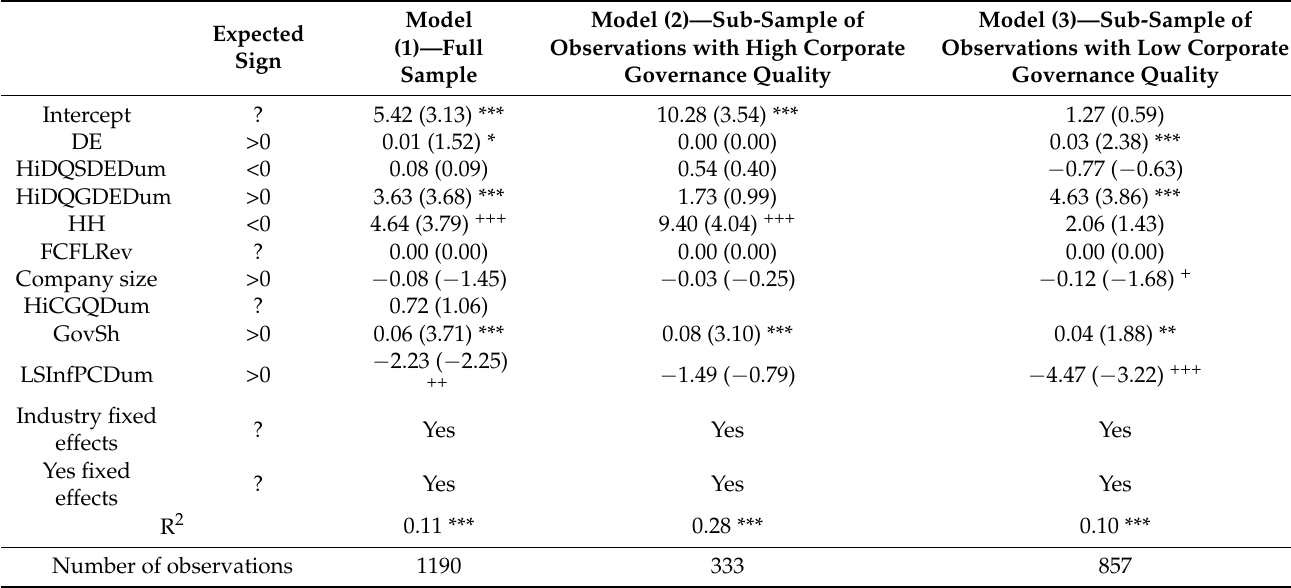
Table A1. OLS estimation of determinants of ∆